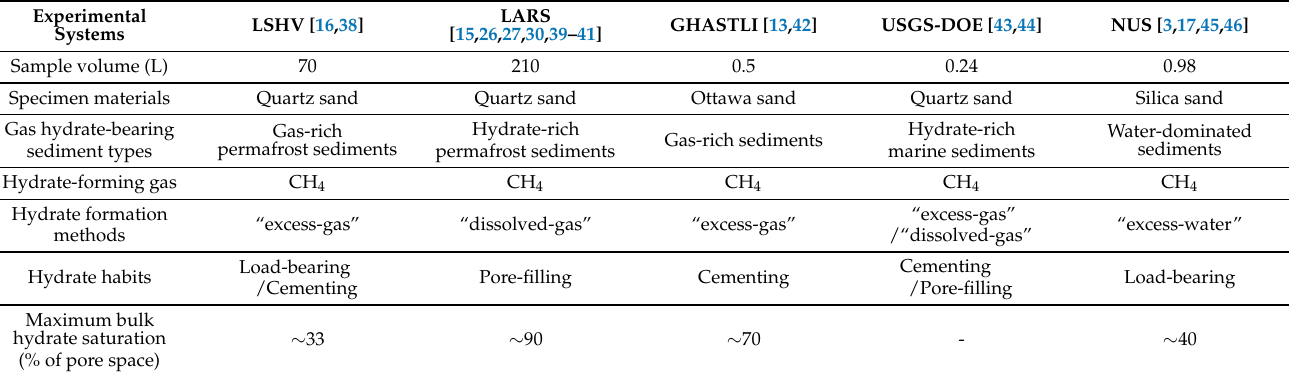
Table 1. Overview of laboratory-scale CH 4 hydrate formation tests conducted in laboratory